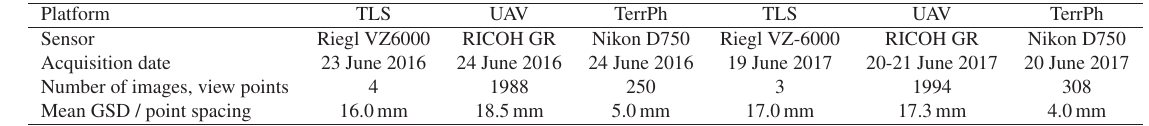
Table 1. Sensor and dataset specifications for the UAV and terrestrial data acquisition in June 2016 and June 2017.